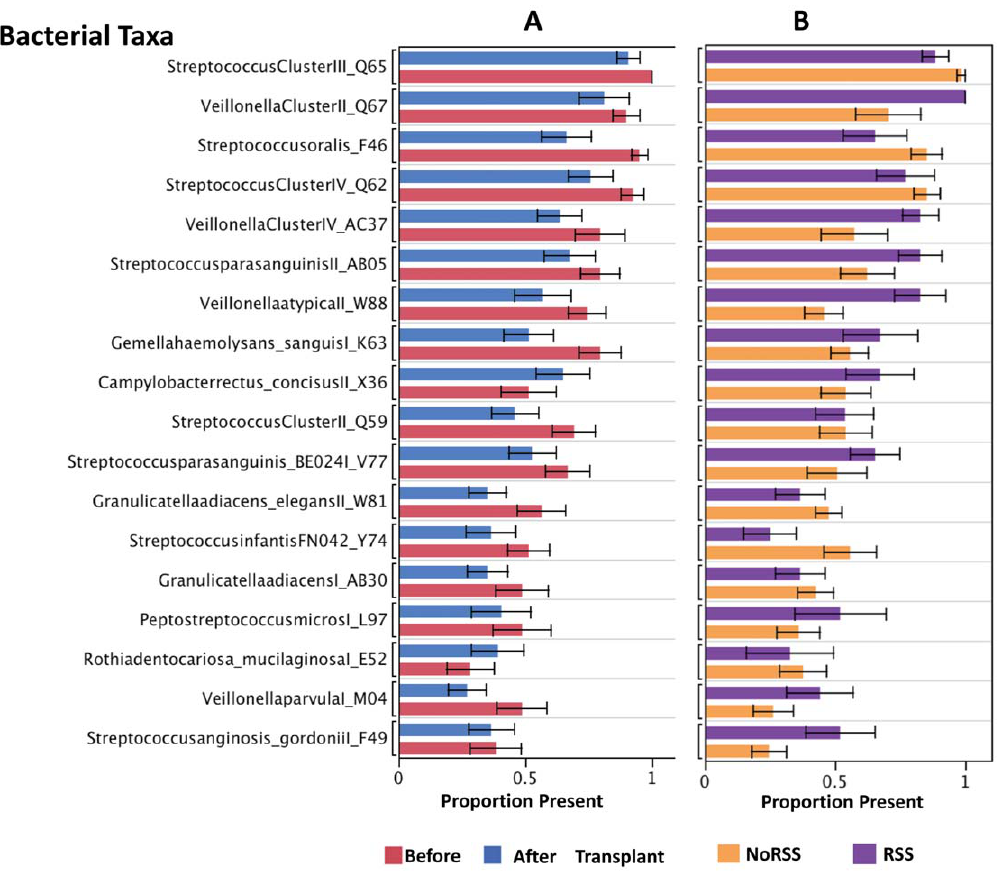
Figure 2. Proportion Present of Common Bacterial Taxa. Eighteen of the most prevalent bacterial probes in the entire sample and their mean proportions are shown. Panel A displays before (red) or after (blue) transplantation and panel B shows patients with NoRSS (orange) or with RSS (purple). The proportion present of each probe and standard error bars are displayed in order according to the mean proportion present (Each error bar is constructed using 1 standard error from the mean.). Each of the eighteen positive probes mean proportions were calculated for all specimens before transplant (n=39), after transplant (n=74) or with NoRSS (n=61) and with RSS (n=52). NoRSS=patients who do not develop respiratory signs and symptoms. RSS=patients who develop respiratory signs and symptoms. Streptococcus Cluster III includes all Streptococcus species; Veillonella Cluster II includes: V.atypica, V.parvula, V.dispar , BU083; Streptococcus Cluster IV includes: S.anginosus, S.intermedius , 17 bases match S. sinensis, S.pneumoniae, S.parasanguis, S.oralis, S.mitis, S.infantis ; Veillonella Cluster IV includes: V.parvula , BU083, V.dispar ; Streptococcus Cluster II includes: